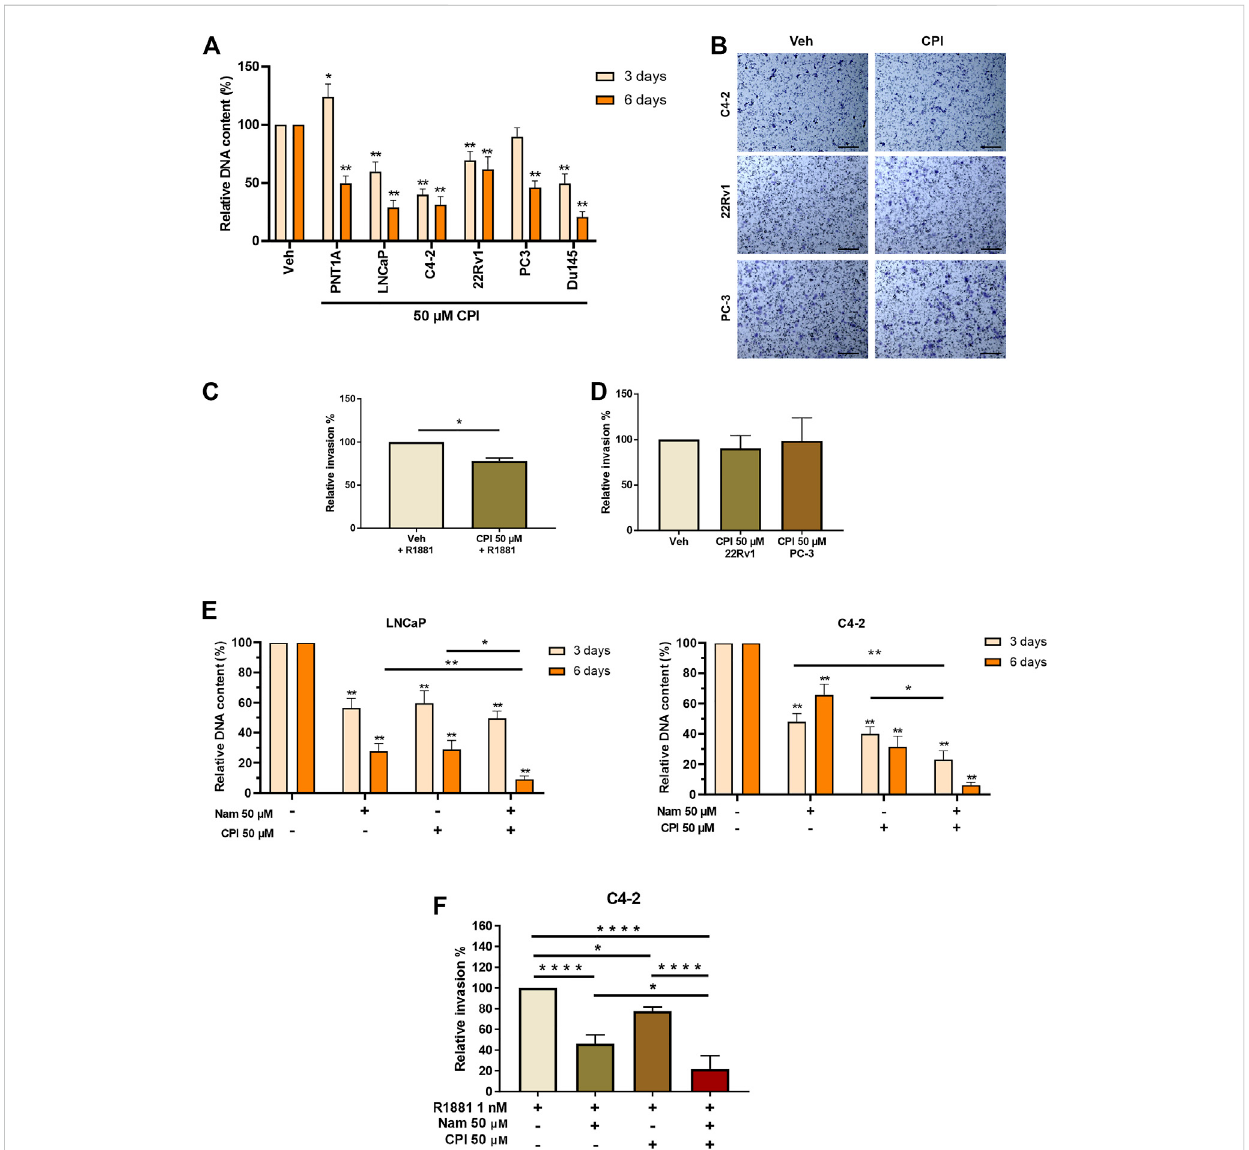
FIGURE 6 PhenotypiceffectsofKDM5inhibitorandKDM1AinhibitorcombinationtreatmentsinPCacelllines. (A) Proliferationwasquanti fi edbyexaminingthe relative DNA content between Vehicle control (0.1% DMSO) and CPI-455 (50 µM) treatment in non-malignant PNT1A and PCa cell lines, LNCaP, LNCaP: C4-2, 22RV1, PC3, and DU145. Measurements were taken at 3 and 6 days after treatment. (B) Representative images of invasion assays of vehicle control and CPI treatment for PCa cell lines LNCaP:C4-2, 22RV1, and PC-3. Scale bar represents 200 µM. Cells were fi xed and stained 24 h after inhibitor treatment. Relative percentage invasion to vehicle control is shown (C) LNCaP:C4-2 and (D) 22RV1 and PC-3. (E) Proliferation assay showing the relative DNA content 3 and 6 days after inhibitor combination treatment with CPI-455 (50 µM) and Namoline (50 µM). (F) Invasion assay for inhibitor drug combinations for LNCaP:C4-2.Veh – Vehicle control 0.1% DMSO, Nam -Namoline,CPI – CPI-455. Signi fi cance shown by p -values * p ≤ 0.05, ** p ≤ 0.005, *** p ≤ 0.001, * p ≤